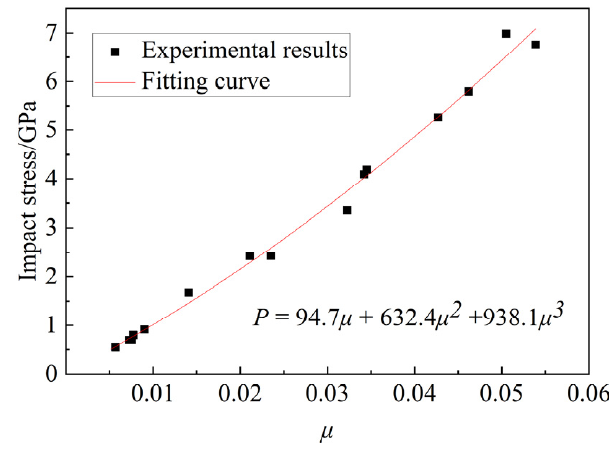
Figure 4. Description of data processing method for the values of K 1, K 2, K 3.